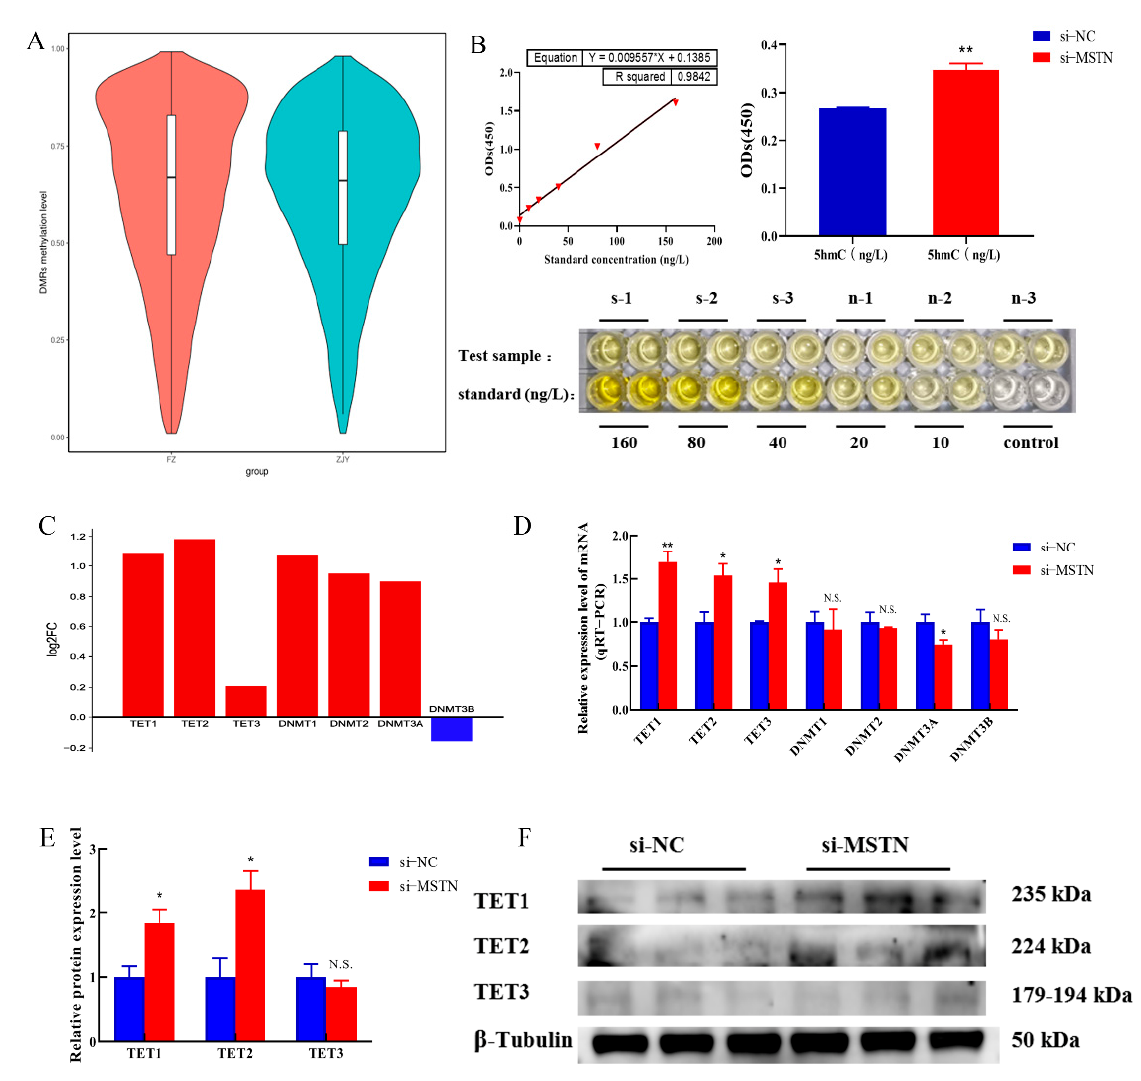
Figure 3. DNA methylation pattern resulting from myostatin editing. ( A ) Violin diagram of WGBS- seq data. ( B ) Hydroxymethylcytosine (5hmC) hydroxylase TET activity assay. Standardized fitted curve of 5hmc activity assay (top left), quantitative results of 5hmc activity assay (top right), and ELISA assay well plot (bottom). ( C ) Histogram of upregulation or downregulation of DNMT and TET family genes in RNA-seq. ( D ) qRT-PCR detection of transcription level of DNMT and TET fam- ily genes. ( E ) Quantitative analysis results of protein gray value. ( F ) Representative bands of the TET family. Differences between groups were statistically analyzed using Student’s t-test. p < 0.05 was considered statistically significant (* p < 0.05 and ** p < 0.01). And N.S., not significant ( p > 0.05). 3.3. Differentially Methylated Regions (DMRs) of the RACK1 Gene We selected the RACK1 gene (ID: ENSBTAG00000019648) as a target gene for further investigation. Deletion of myostatin resulted in increased transcript levels of RACK1 ( p < 0.01), MyHC ( p < 0.05), and MyoG ( p > 0.05) (Figure 4B). We used 50 mmol/L Bobcat339 to interfere with the DNA demethylation pathway of cells (Figure 4A), which resulted in non-significant changes ( p > 0.05) in the transcript levels of RACK1, MyHC, and MyoG, although myostatin expression was inhibited (Figure 4C). Overall, the impairment of the